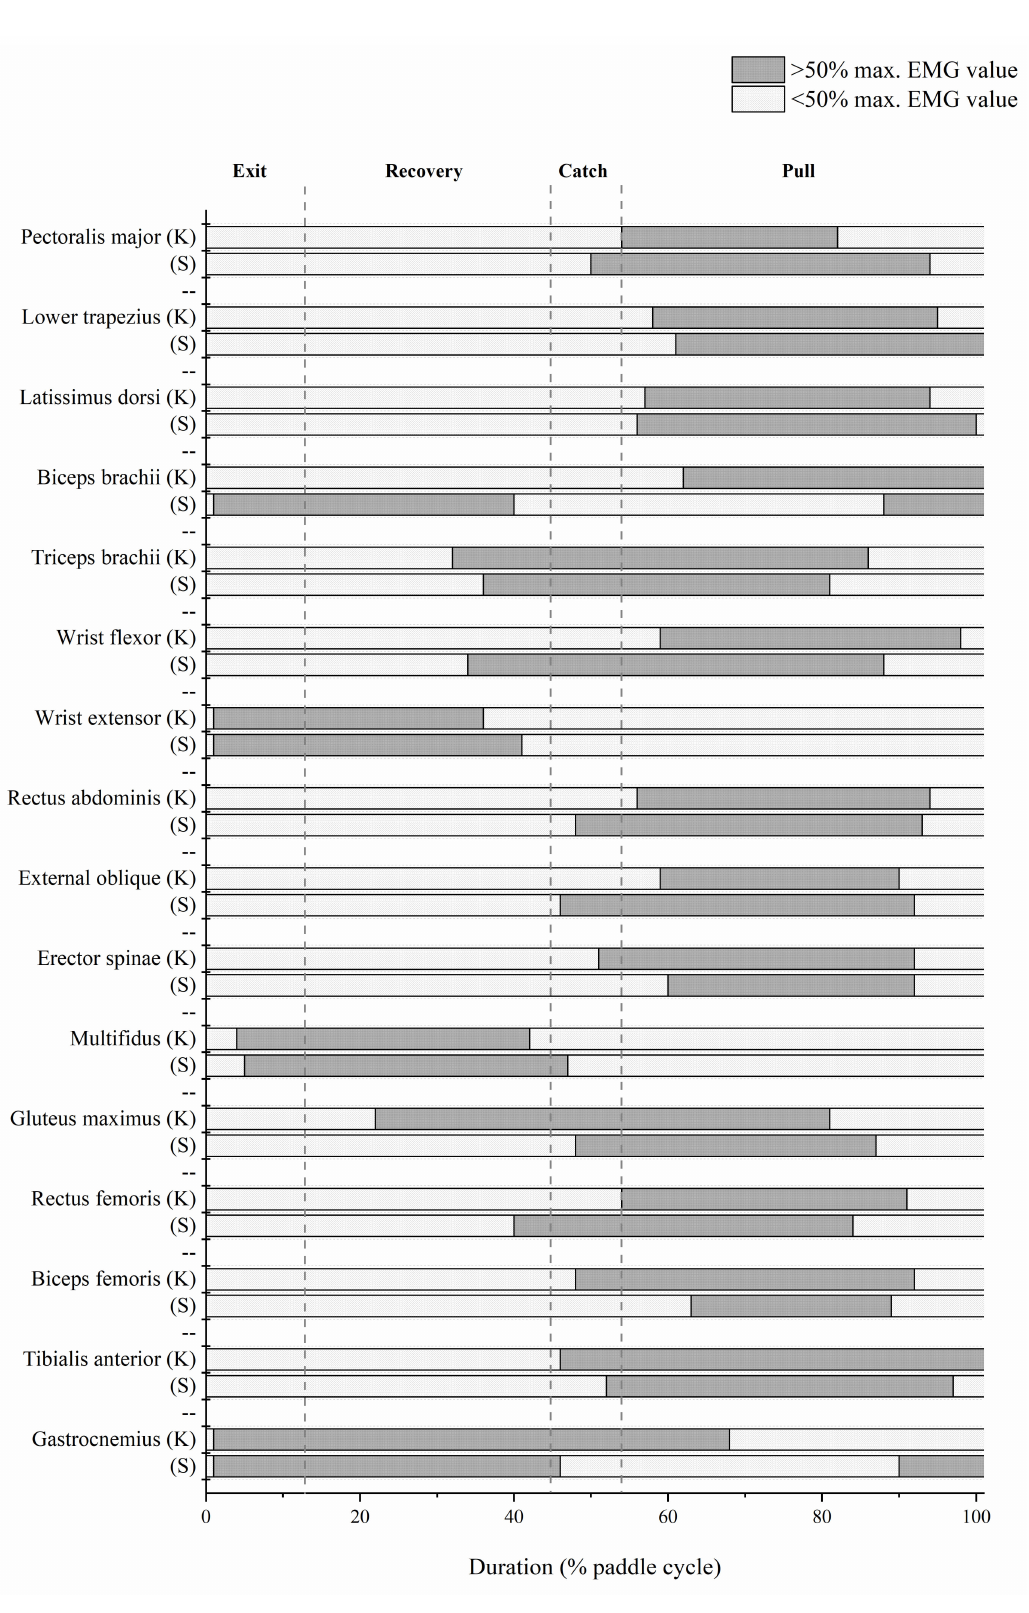
Figure 2. Muscle activation sequence in di ff erent stages of paddling in di ff erent postures. (K): kneeling position; (S): standing